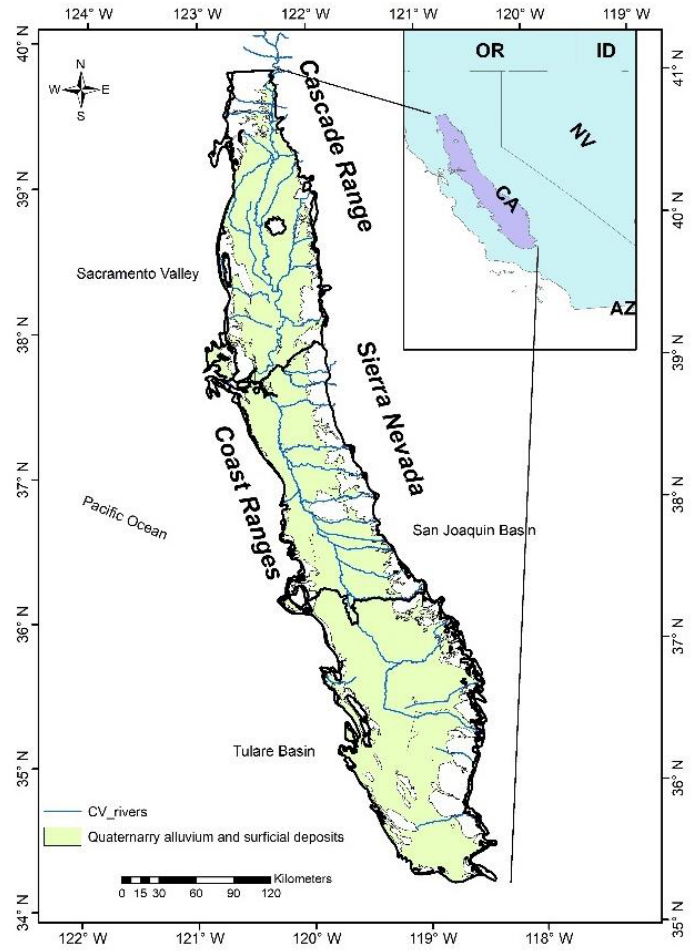
Figure 1. Central Valley Aquifer System.